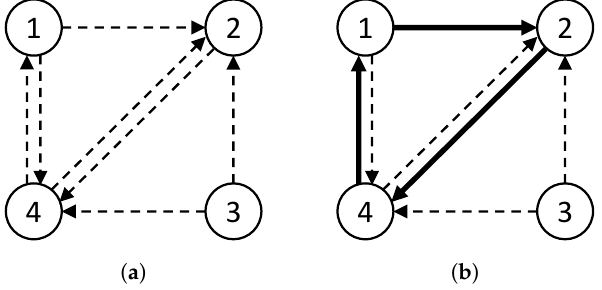
Figure 2. Kidney exchange program (KEP) graph ( a ) and its feasible solution ( b